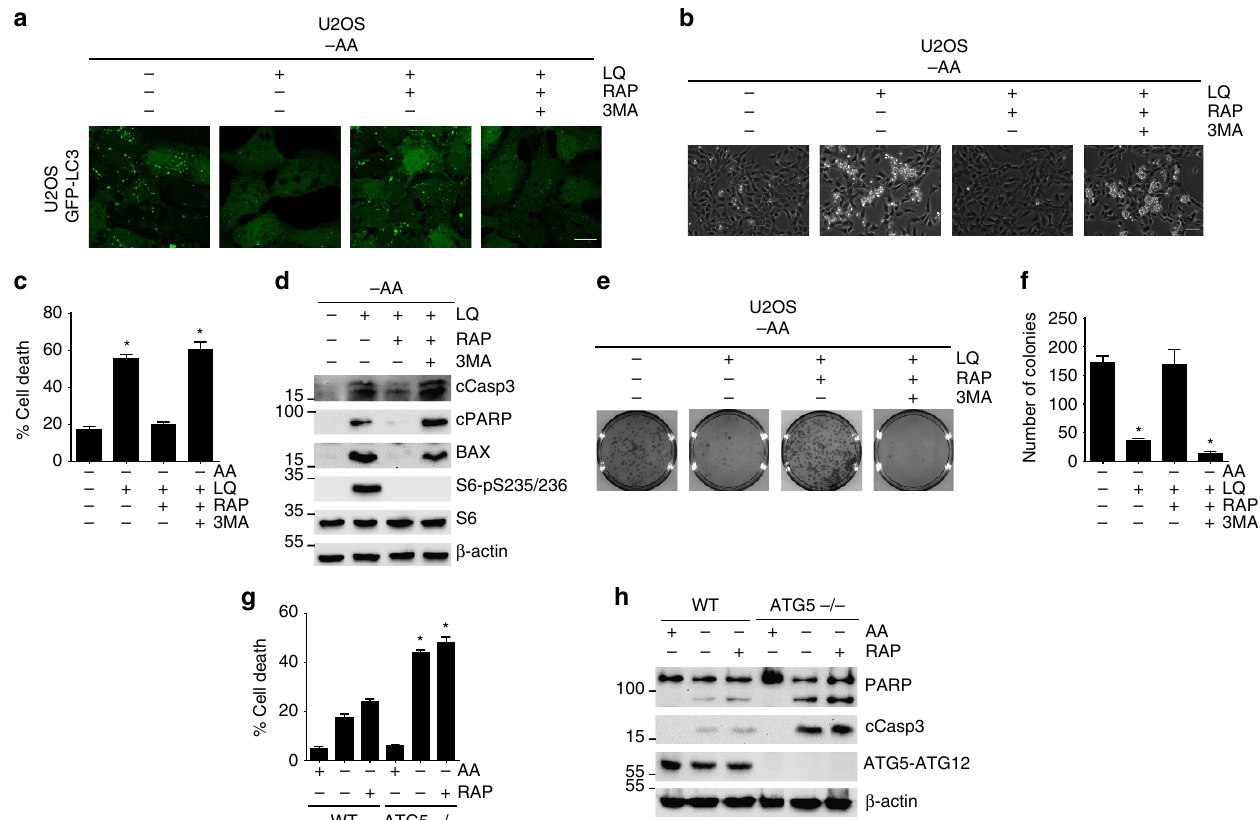
Figure 5 | Autophagy was necessary for the ability of rapamycin treatment to prevent glutaminolysis and mTORC1 induced apoptosis. ( a ) GFP-LC3 expressing U2OS cells were starved for amino acids in the presence or absence of LQ, RAP and 3MA for 72h as indicated. Autophagosome formation upon GFP-LC3 aggregation was determined using confocal microscopy. The scale bar represents 20 m m. ( b ) U2OS cells were starved for all the amino acids in the presence or absence of LQ, RAP and 3MA for 72h as indicated. A representative microscopy image of the cells for the indicated conditions is shown. The scale bar represents 100 m m. ( c ) Percentage of cell death as estimated using trypan blue exclusion assay in U2OS treated as in b . ( d ) Western blot analysis of apoptotic markers and mTORC1 downstream targets was assessed for U2OS cells treated as in b . ( e , f ) Clonogenic assay of U2OS cells treated as in b ( e ). The number of colonies in three independent experiments was quantified ( f ). ( g , h ) WTand ATG5 (cid:2) / (cid:2) MEFs were incubated either in the presence ( þ AA) or the absence ( (cid:2) AA) of amino acids ( þ AA) and rapamycin as indicated for 24h. Cell viability using trypan blue exclusion assay ( g ) and western blot analysis of apoptotic markers ( h ) are shown. Graphs show mean values ± s.e.m. ( n ¼ 3). * P o 0.05 (Anova post hoc